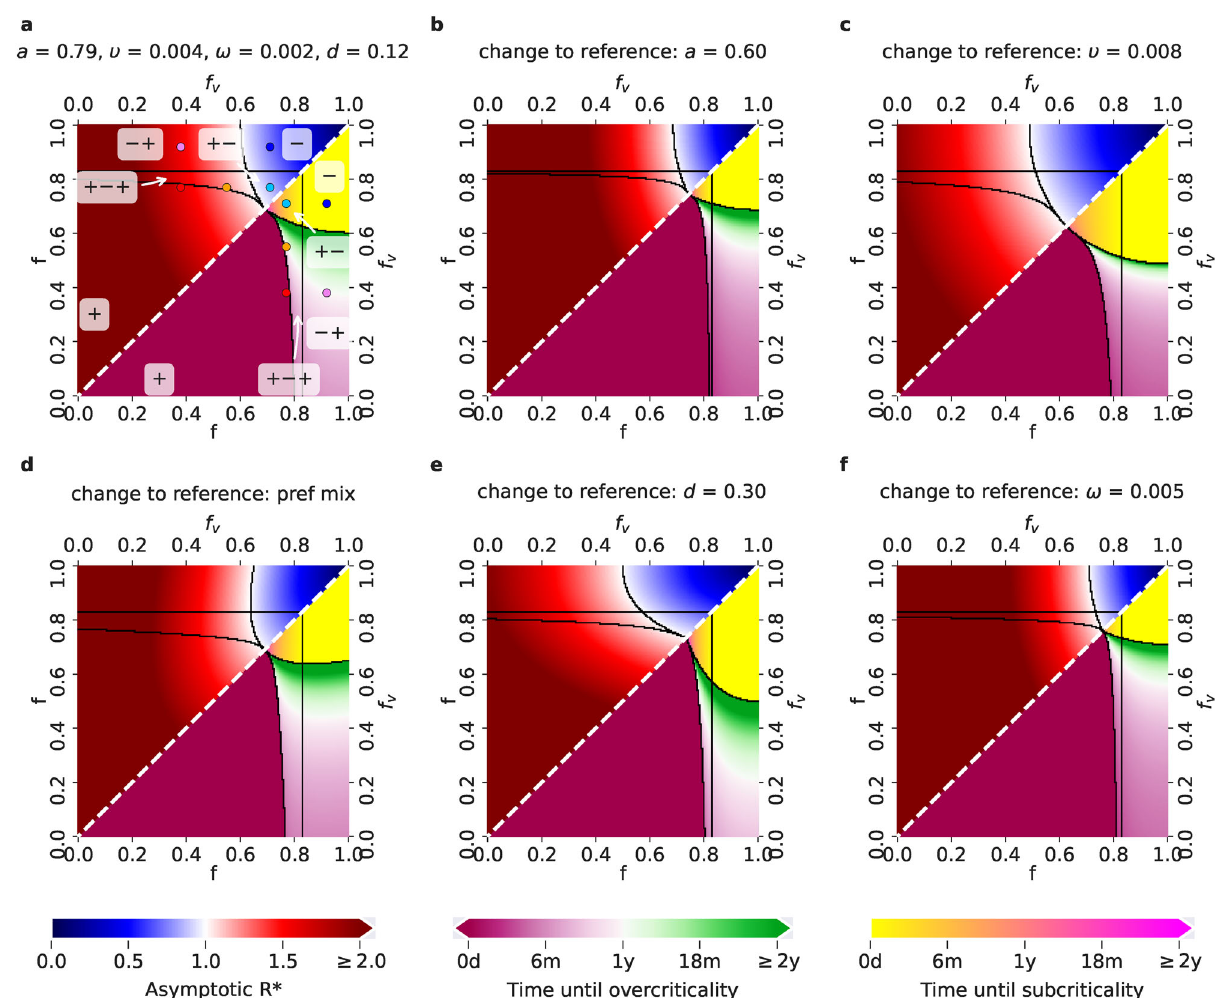
Fig. 2 Possible COVID-19 epidemic dynamics for different parameter setups for the Delta variant. The relevant f − f v parameter space, where f v ≤ f , can be divided into fi ve regions (delimited by black borders), each associated with a different behavior of the epidemics. On the diagonal (white dashed line), f = f v , i.e., the restrictions for VP holders and for the rest of the population are the same - corresponding to the situation when VPs are not introduced at all. Lower triangles show the time until the last critical threshold: different color scales correspond to the time until the switch either from a subcritical to an overcritical epidemic (time until overcriticality, violet-green scale), or from an overcritical to a subcritical epidemic (time until subcriticality, yellow-pink scale). Upper triangles show the asymptotic R (cid:3) , as a function of the values of f and f v (blue-red scale, with blue associated with R (cid:3) < 1 and red associated with R (cid:3) > 1). a Reference setup, with a = 0.79 (corresponding to the effectiveness of the Comirnaty vaccine on the Delta variant), υ = υ r = 0.004, ω = 0.002, d = 0.12 (fraction of never-vaccinated in the United Kingdom) and proportional mixing. The choices of ( f , f fi ve scenarios v ) corresponding to the exempli fi ed in Fig. 1c are denoted by points of the same color. b Setup with a decreased vaccine effectiveness: a = 0.6 (corresponding to the effectiveness of the Vaxzevria vaccine on the Delta variant). c Setup with an increased vaccination rate: υ = υ r = 0.008. d Setup with preferential (instead of proportional) mixing. e Setup with an increased fraction of people who will not get vaccinated: d = 0.3 (fraction of never-vaccinated in France). f Setup with an increased waning rate: ω = where Asymptotic structure of the population and minimum common restrictions required to avoid epidemic resurgence . The asymptotic structure of the population in terms of the sizes of the sub- populations V , S V and S D can be easily obtained by setting I = I V = R = R V = 0 and computing the stable stationary solution for can be seen as the actual immunization rate in the population, of our ODE system (1): V as , S as and S as V and is expressed as a function of vaccine effectiveness a and the ratio of the immunity waning rate ω and the revaccination rate υ r . The obtained values correspond to the structure in the limit t → ∞ and represent the structure to which the population con- verges in the long term. Having this, we obtain the asymptotic instantaneous reproduc- tion number R (cid:3) by inserting the asymptotic values S as and S as V into Eq. (6). These values are plotted in the upper triangles in the panels of Fig. 2 and Supplementary Fig. S3 in the main text.